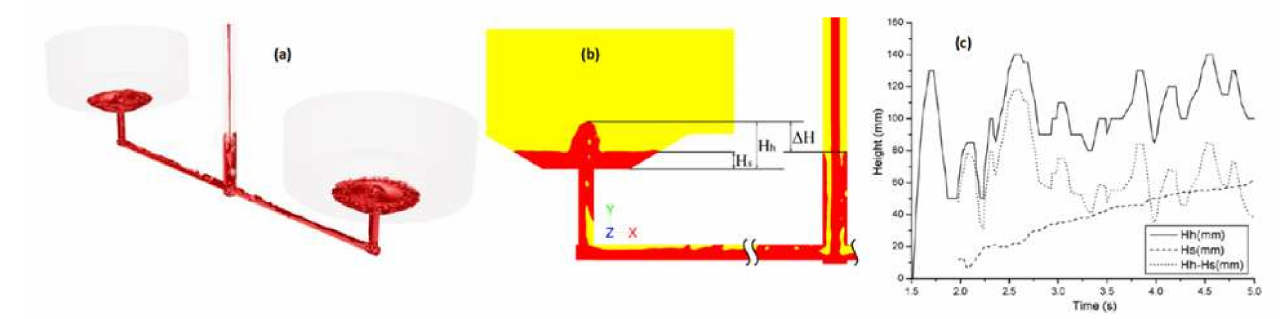
Figure 3. Initial mold-filling phase ( a ), schematic presentation of characteristic heights ( b ), and values of characteristic heights as a function of time ( c ) [20].